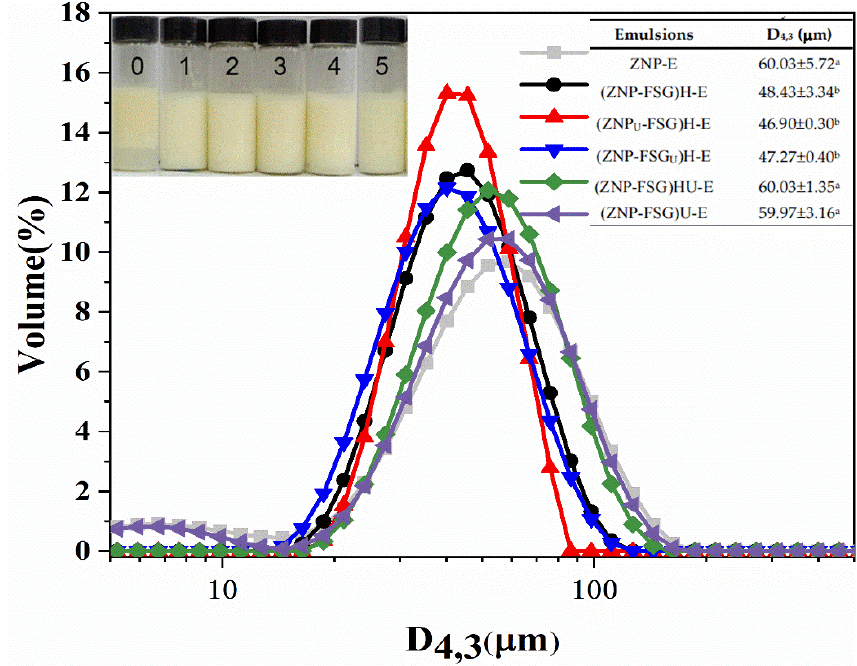
Figure 8. The particle size distribution of emulsions stabilized by ZNP-FSG complexes subjected to various ultrasound and homogenization treatments. Insets are photographs of fresh emulsions (0. ZNP-E, 1. (ZNP-FSG)H-E, 2. (ZNP U -FSG)H-E, 3. (ZNP-FSG U )H-E, 4. (ZNP-FSG)HU-E, 5. (ZNP- FSG)U-E). The emulsion droplets sizes are shown in the